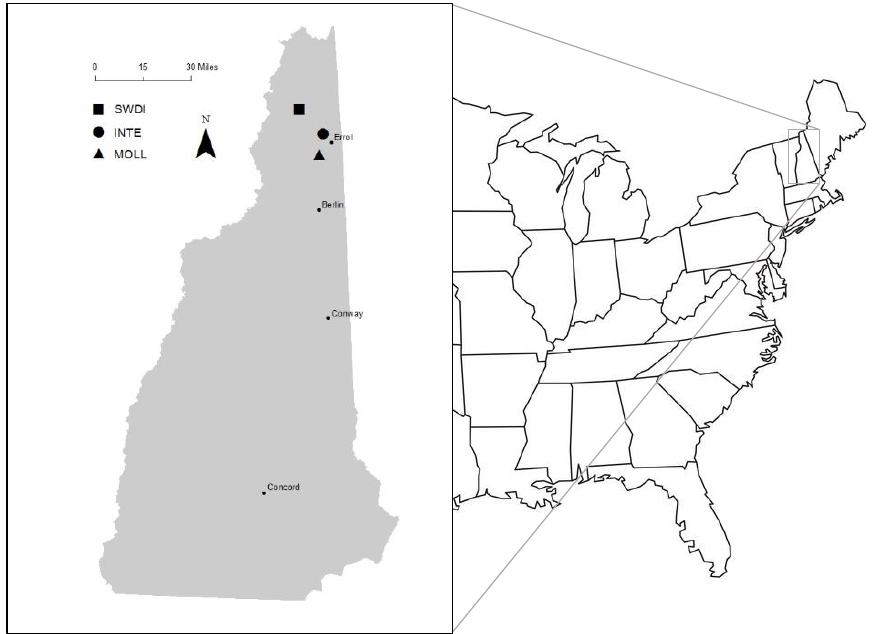
Figure 1. Drainages and their locations relative to the nearest township of Errol, Coos County, New Hampshire within the USA. Symbols indicate approximate site locations from 2010 − 2012 and include Swift Diamond (SWDI), Interior (INTE), and Mollidgewock (MOLL).